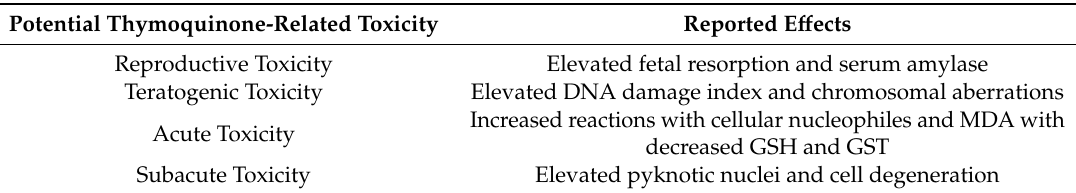
Table 2. The potential thymoquinone-related toxicity and its reported e ff ects. Potential Thymoquinone-Related Toxicity Reported E ff ects Reproductive Toxicity Elevated fetal resorption and serum amylase Teratogenic Toxicity Elevated DNA damage index and chromosomal aberrations Increased reactions with cellular nucleophiles and MDA with Acute Toxicity decreased GSH and GST Subacute Toxicity Elevated pyknotic nuclei and cell